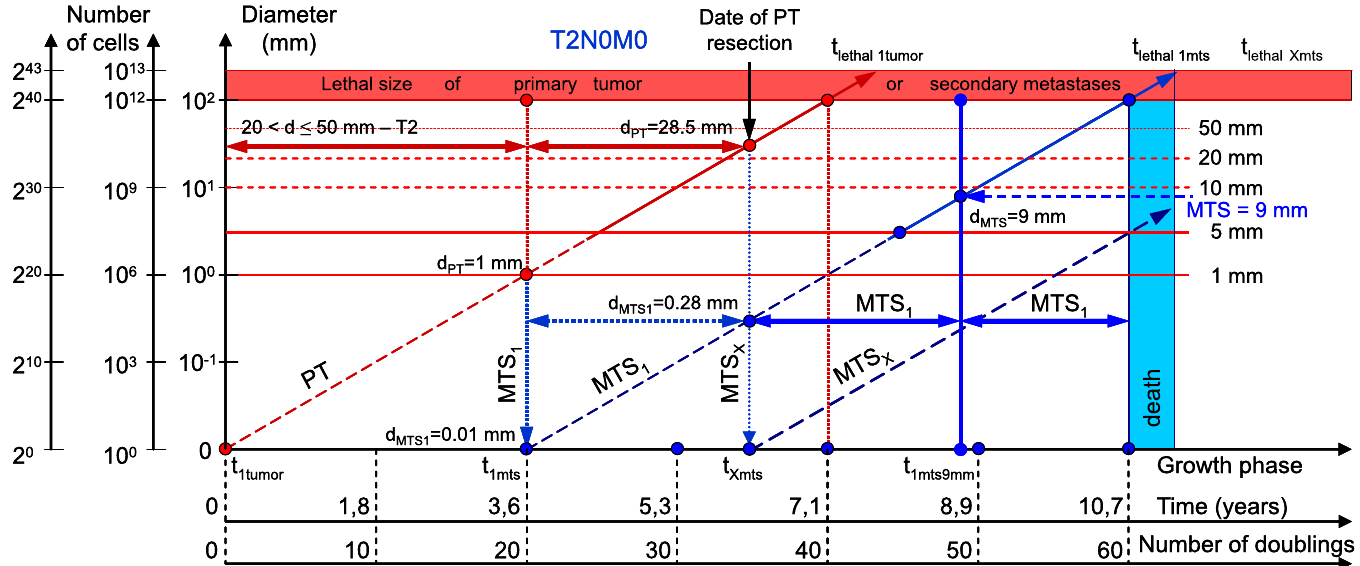
Fig 6. T2N0M0. The whole natural history of PT and secondary distant MTS of patients without lymph nodes MTS via CoMPaS. Parameter T2: 20 mm < d (cid:20) 50 mm. Diameter of PT at surgery of PT: d PT = 28.5 mm. Diameter of secondary distant MTS at surgery of PT: d MTS = 0.28 mm.